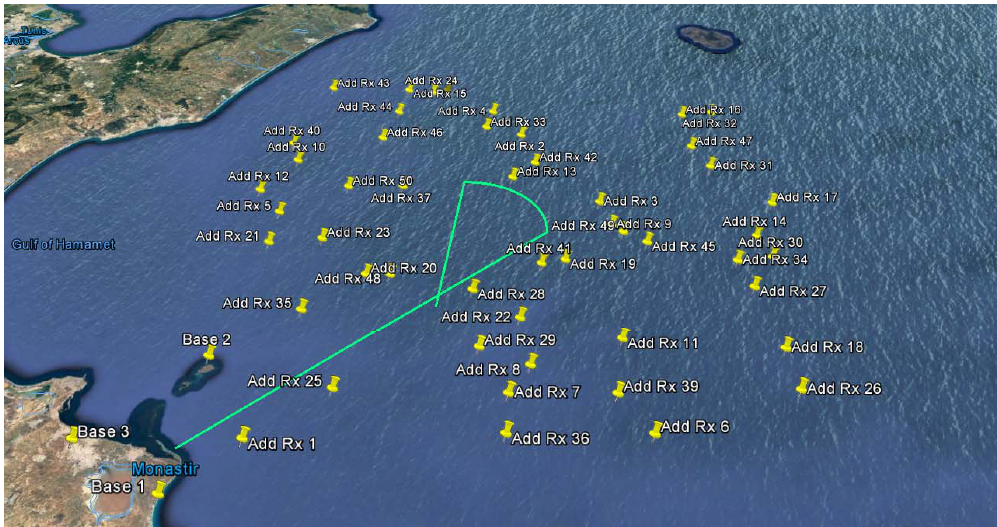
Figure 6. Position of the three high-end coastal stations ( Base # ) and of the additional low-cost receivers ( Add Rx # ). The simulated trajectory of the target vessel, leaving the Tunisian coast and heading toward Pantelleria island, is represented by a cyan